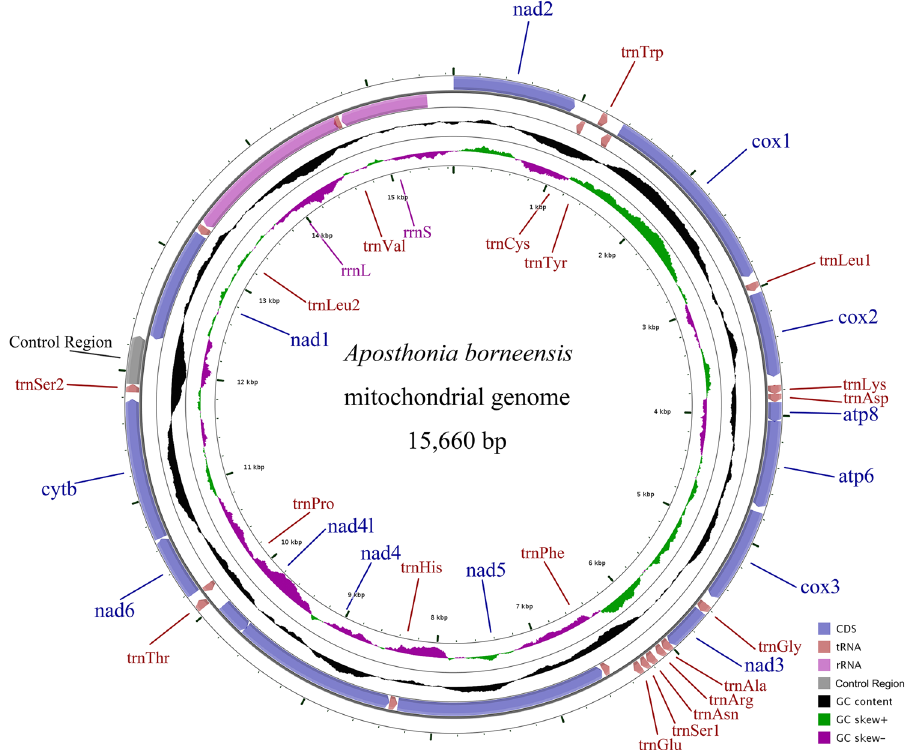
Figure 1. Mitochondrial map of A. borneensis. Genes outside the map are transcribed in a clockwise direction, whereas those inside the map are transcribed counterclockwise. The second circle shows the GC content and the third shows the GC skew. GC content and GC skew are plotted as the deviation from the average value of the entire sequence.